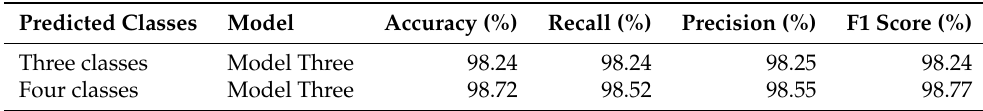
Table 7. Performance metrics of the best model among the three models for both three and four classes on the validation dataset.